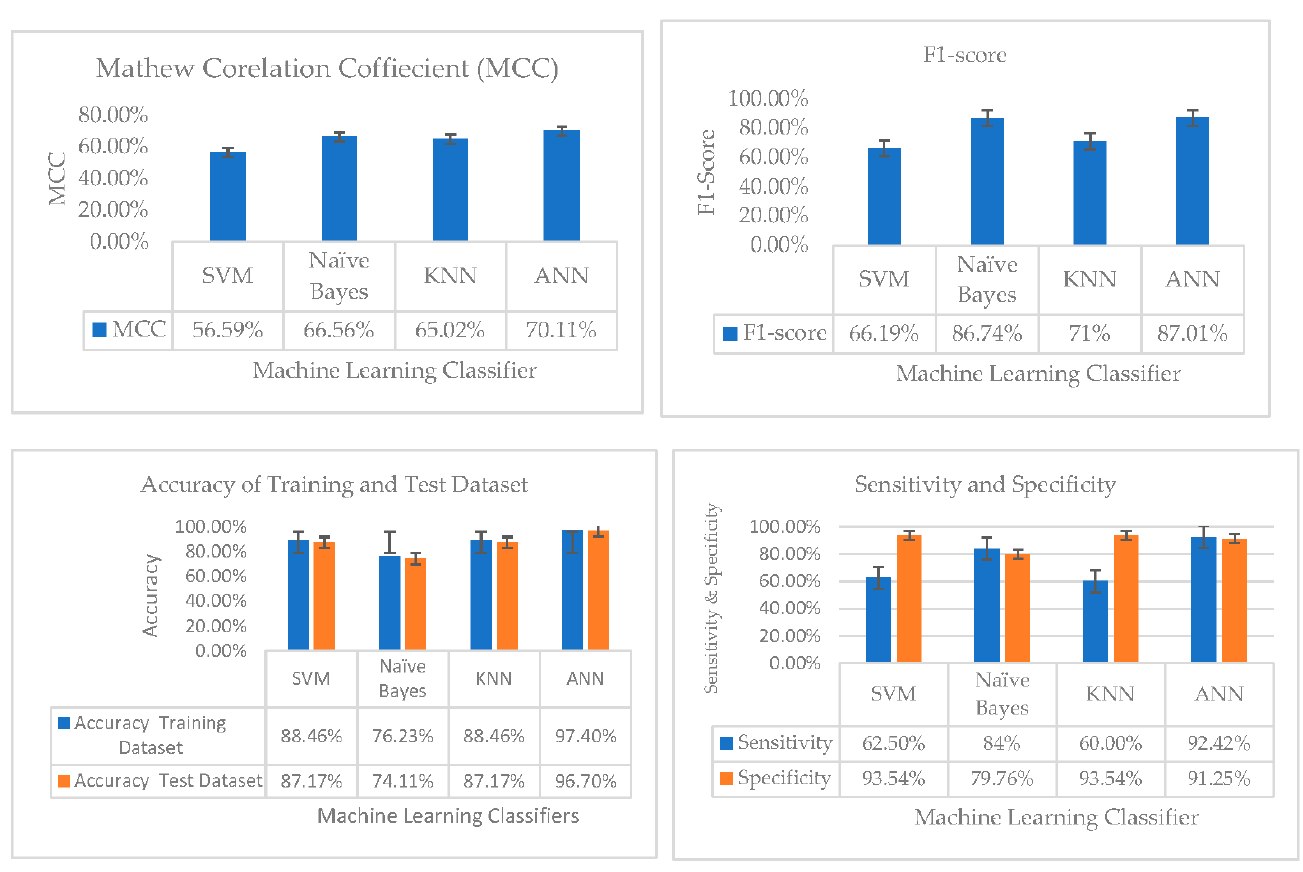
Figure 10. Graphical representation of distributions of performance measures for all classifiers.